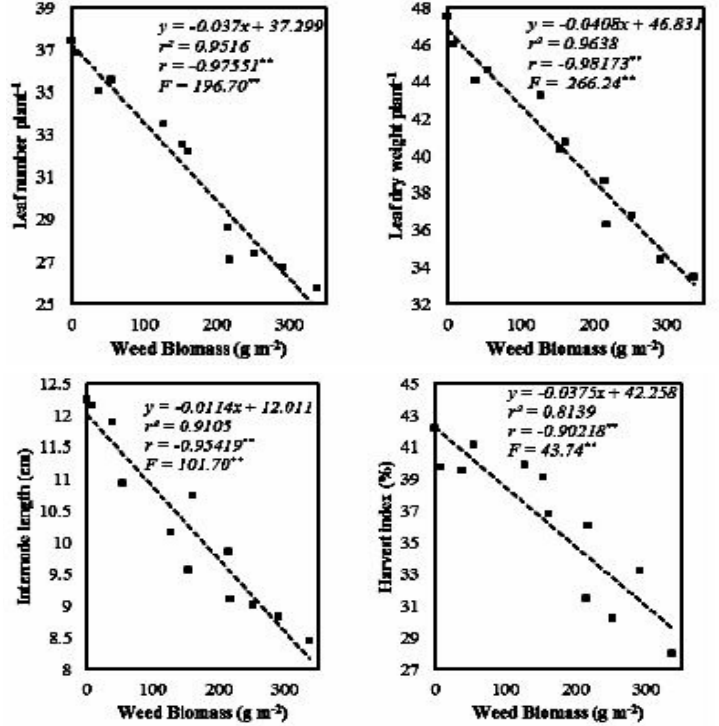
Fig. 4. Relationships between weed biomass and different traits of dry bean; ** : significance at